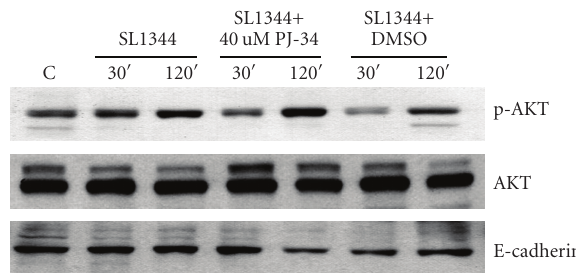
Figure 4: E ff ect of PJ-34 on Salmonella-activated intracellular signals . Caco-2 cells were left untreated, or treated with 40 μ M PJ-34, and then infected with wild-type S . Typhimurium strain SL1344 for the times indicated. Activation of the AKT pathway was analyzed in cell fraction (membrane part) by immunoblotting with antibodies to phosphorylated (p) AKT and total AKT. E-cadherin works as a normalization of membranous protein. The results shown are representative of 3 separate experiments. The activation and recruitment of Akt were not significantly suppressed by